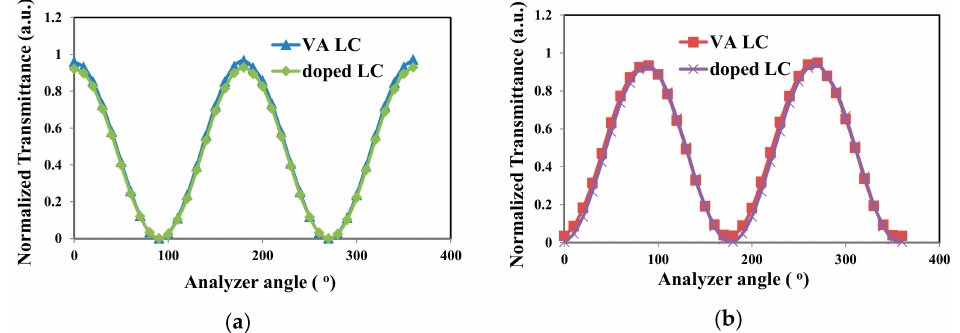
Figure 5. Transmission of 0.1 wt %-gelator-doped LCT-06441 and VA host LC cells positioned between two polarizers, with the analyzer axis rotated relative to the polarizer axis. Angular dependence of the transmission under applied voltages of ( a ) V = 0 V and ( b ) V = 10